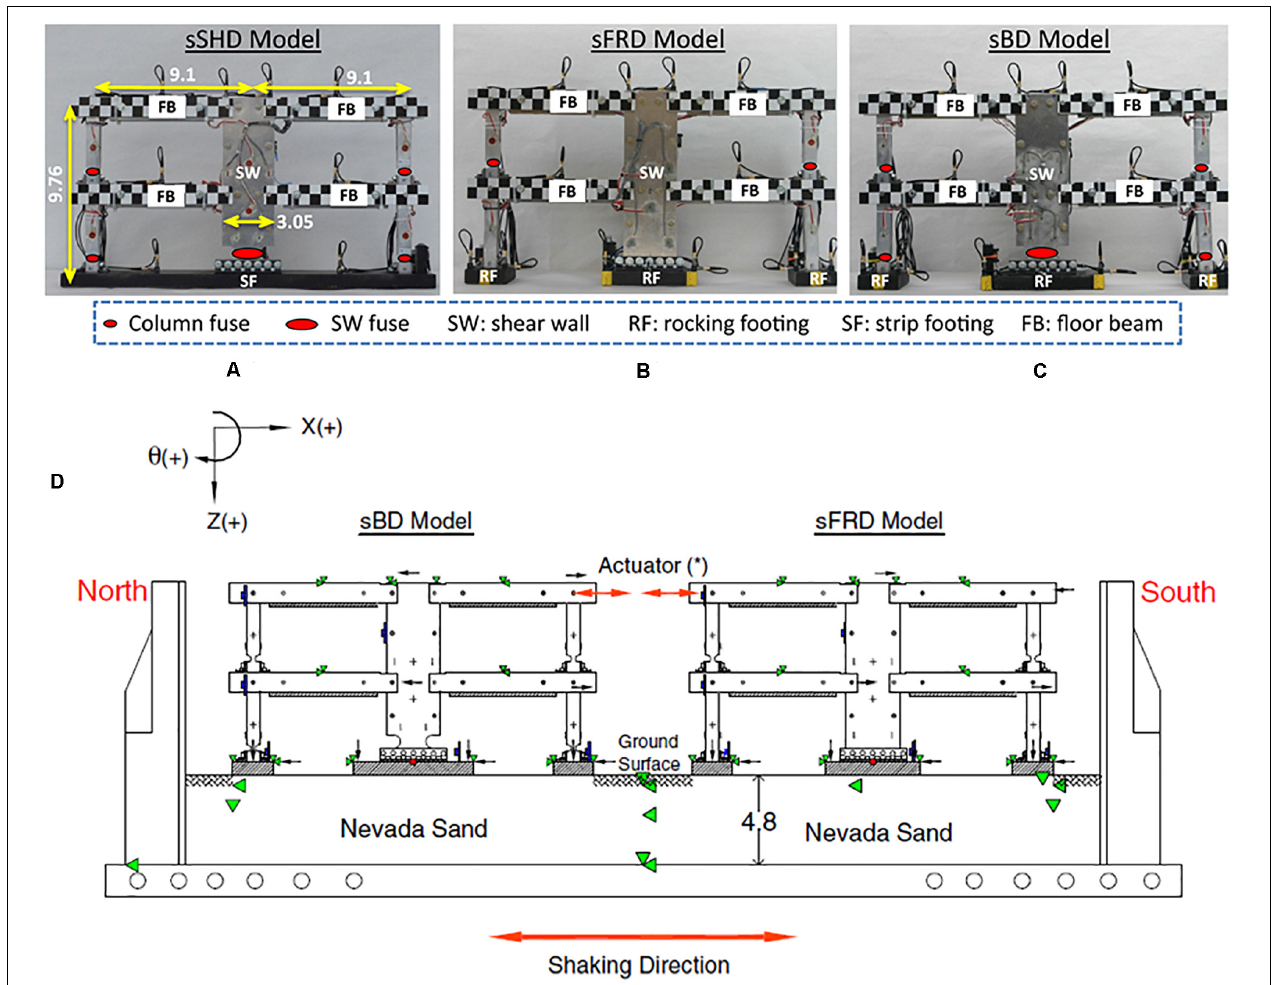
FIGURE 7 | Frame wall-foundation models for testing on the 9-m centrifuge (Liu et al., 2015a): (A) structural hinging dominated SHD model, (B) foundation rocking dominated FRD model, (C) balanced design model BD, and (D) arrangement of models in the soil container for static and dynamic testing on the centrifuge.